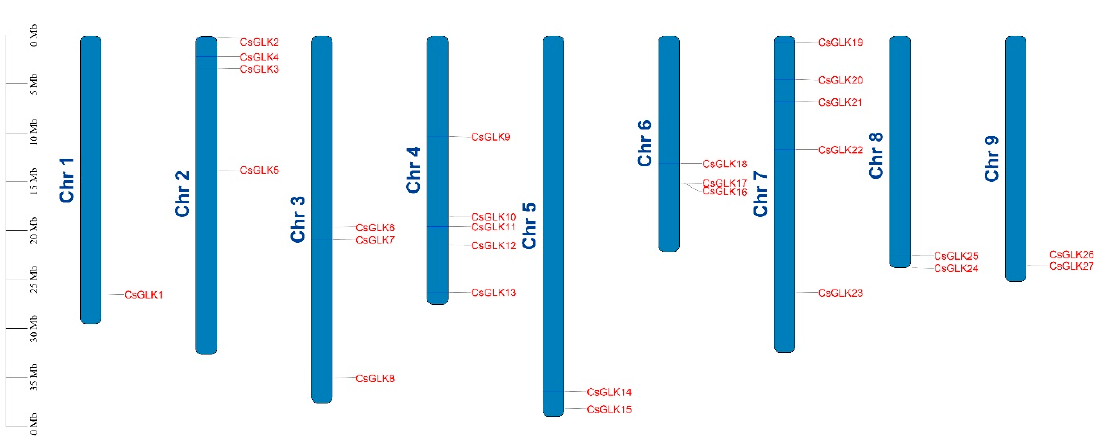
Figure 4. Chromosomal distribution of GLK genes in Citrus. The scale represents 40 Mb chromoso- mal distance.